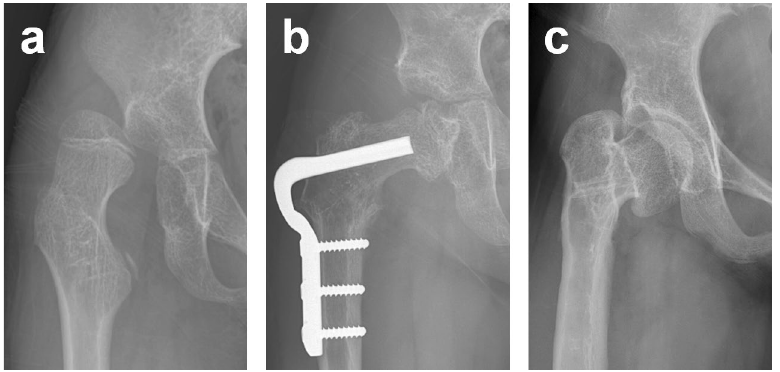
Figure 3. ( a ) Preoperative AP radiograph showing a dislocated hip in an 8-year-old girl. ( b ) AP radiograph showing Type 5 AVN developed after open reduction, VDRO, and pelvic osteotomy. ( c ) At 6 years after surgery, the femoral head was noted to be remodelled without subluxation.